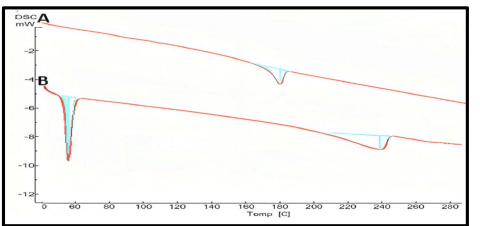
Figure 7. DSC studies of pure curcumin ( A ), the prepared curcumin NLCs-F1 ( B ) with the absence melting peak of curcumin at 180 ◦ C confirming amorphous state plot of mW vs. temp.